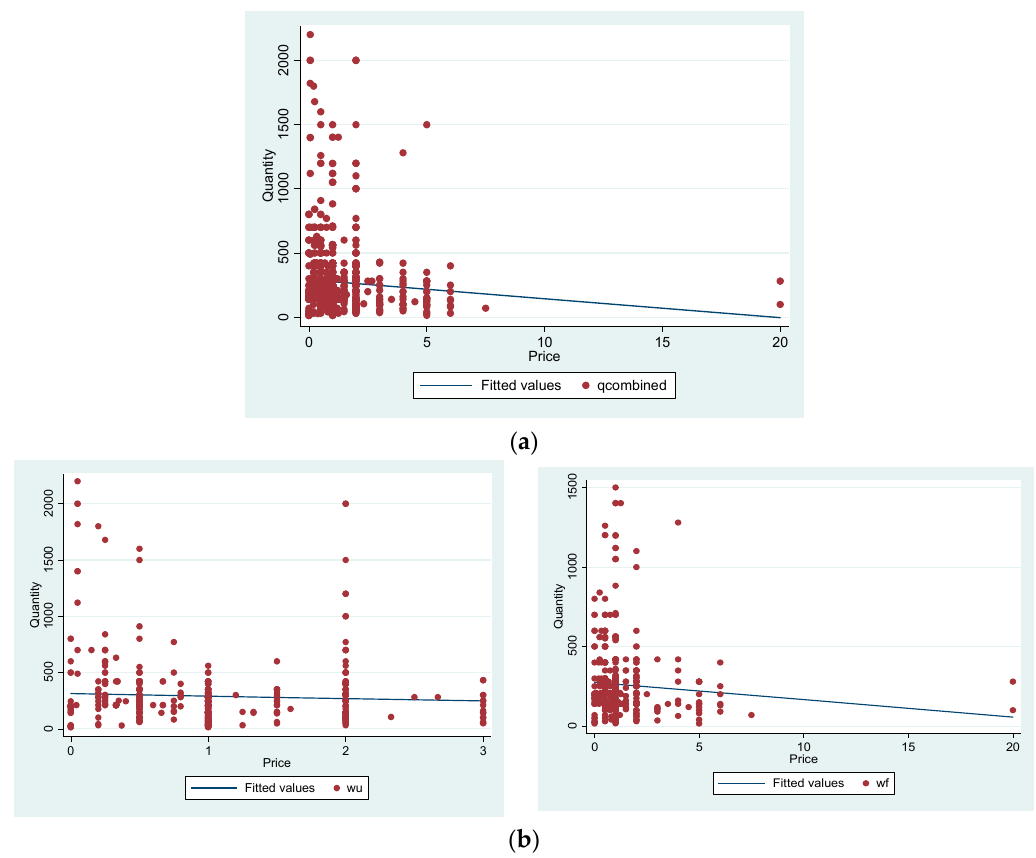
Figure 2. Relationship between Price and Quantity of Water. ( a ) Full sample (combined); ( b ) Filtered and unfiltered water.